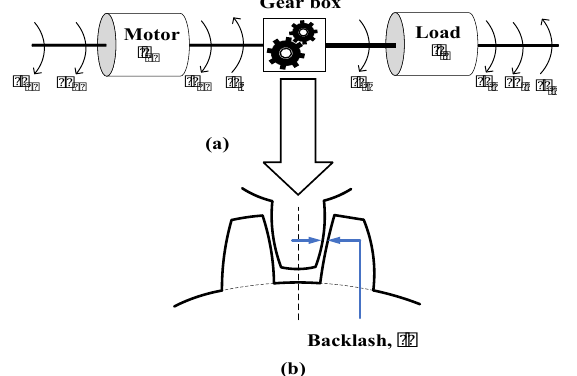
Figure 1. Two mass systems with gearbox